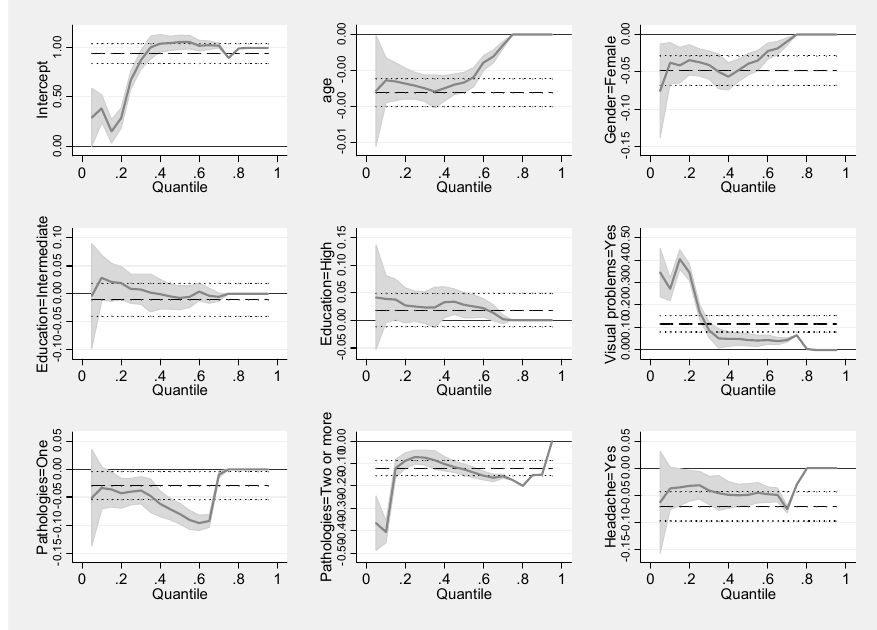
Figura 3 – Point estimates and 95% confidence intervals from a quantile regression of the EQ-5D index